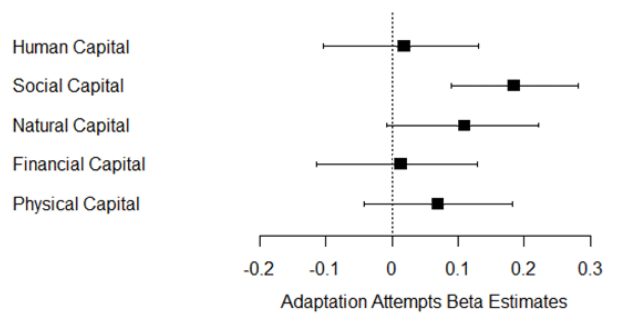
Fig. 3. Plot showing the model-averaged beta estimates for each type of capital for adaptations attempted by a household.